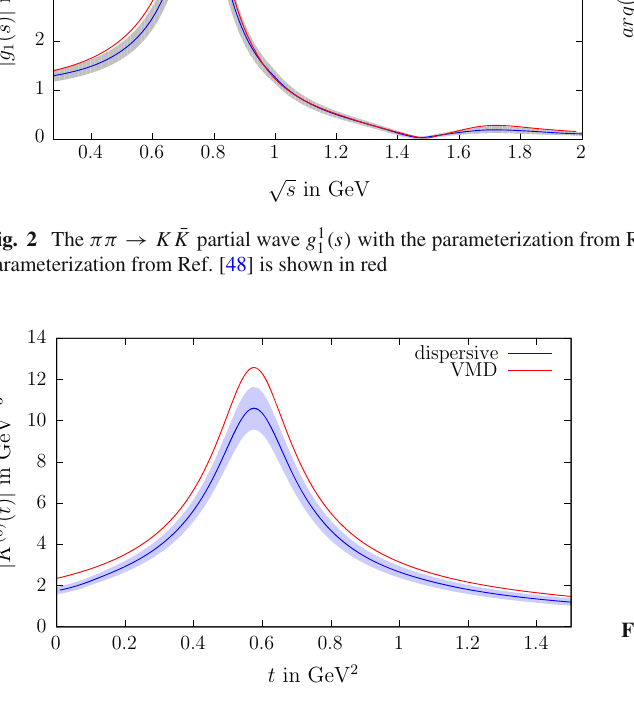
Fig. 3 Comparison of the dispersive solution and the corresponding VMD approximation for the t -channel SVA G ( 0 ) . The uncertainty band on the dispersive solution includes the propagated error of the ππ → ( s ) K ¯ K amplitude g 1 1